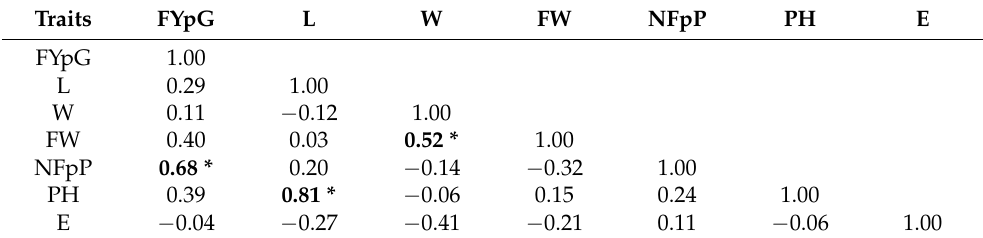
Table 3. Correlation coefficients among the traits of different eggplant genotypes.